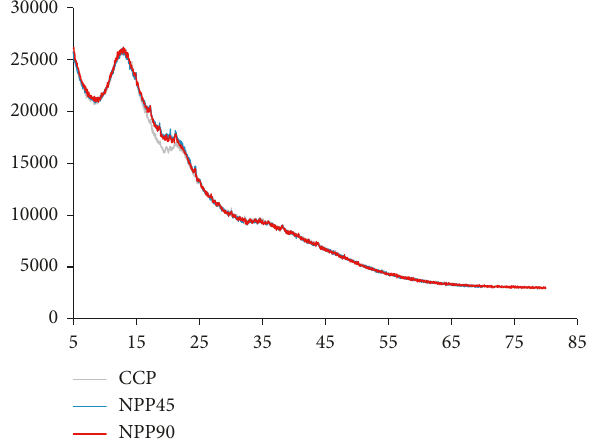
Figure 5: XRD pattern of CPP, NPP45, and NPP